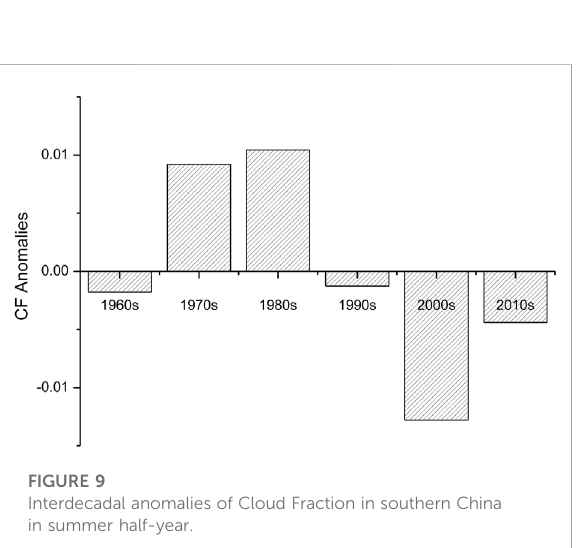
FIGURE 9 Interdecadal anomalies of Cloud Fraction in southern China in summer